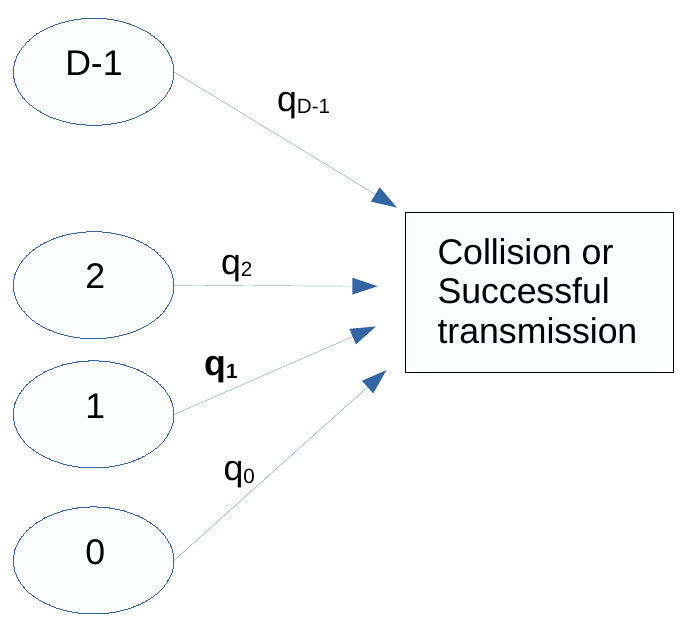
Figure 1. The model under study in this